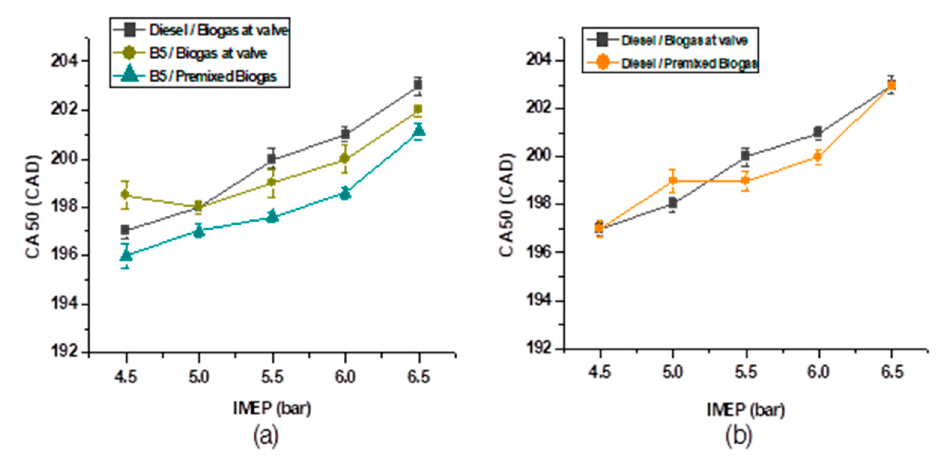
Figure 10. Variation of the combustion phase (CA50) for ( a ) B5 / biogas RCCI in premixed and injection at the valve and ( b ) diesel / biogas in a premixed and port injection at the valve.